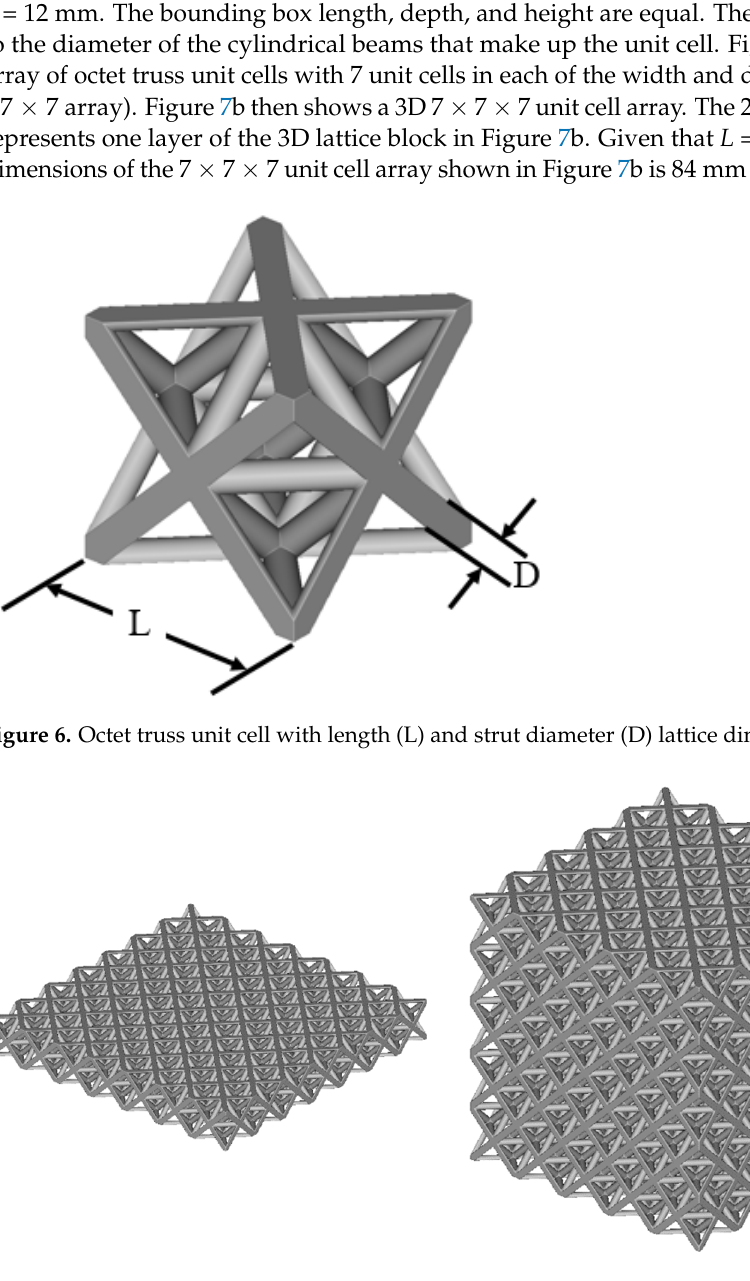
Figure 7. ( a ) 7 × 7 array of octet truss unit cells; ( b ) 7 × 7 × 7 array of octet truss unit cells.